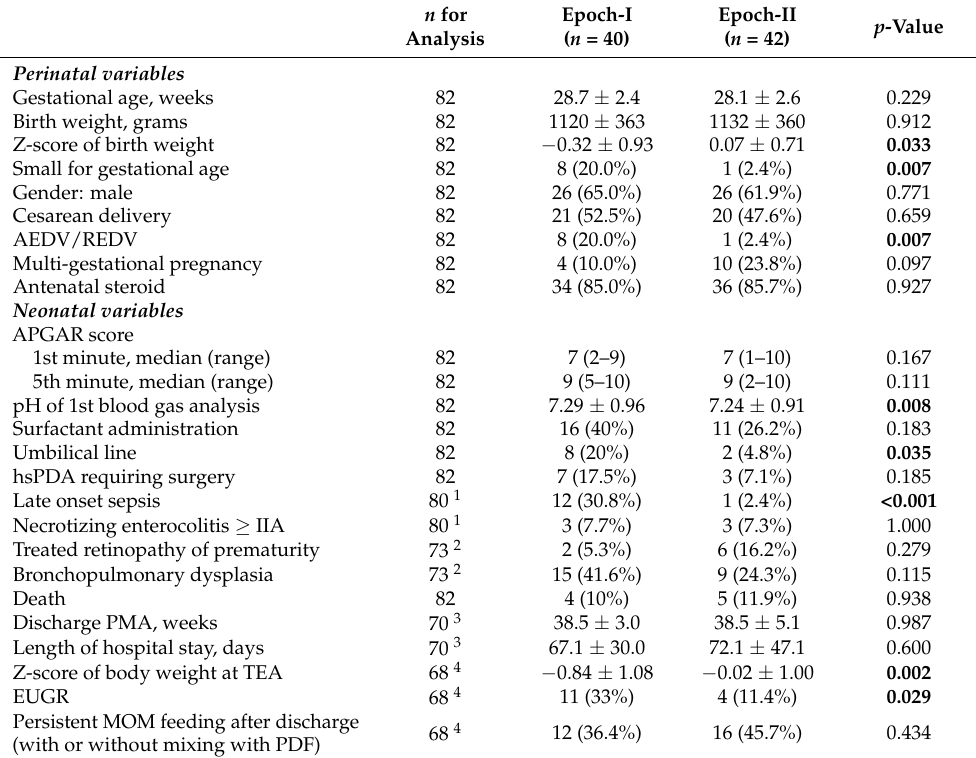
Table 1. Baseline demographic